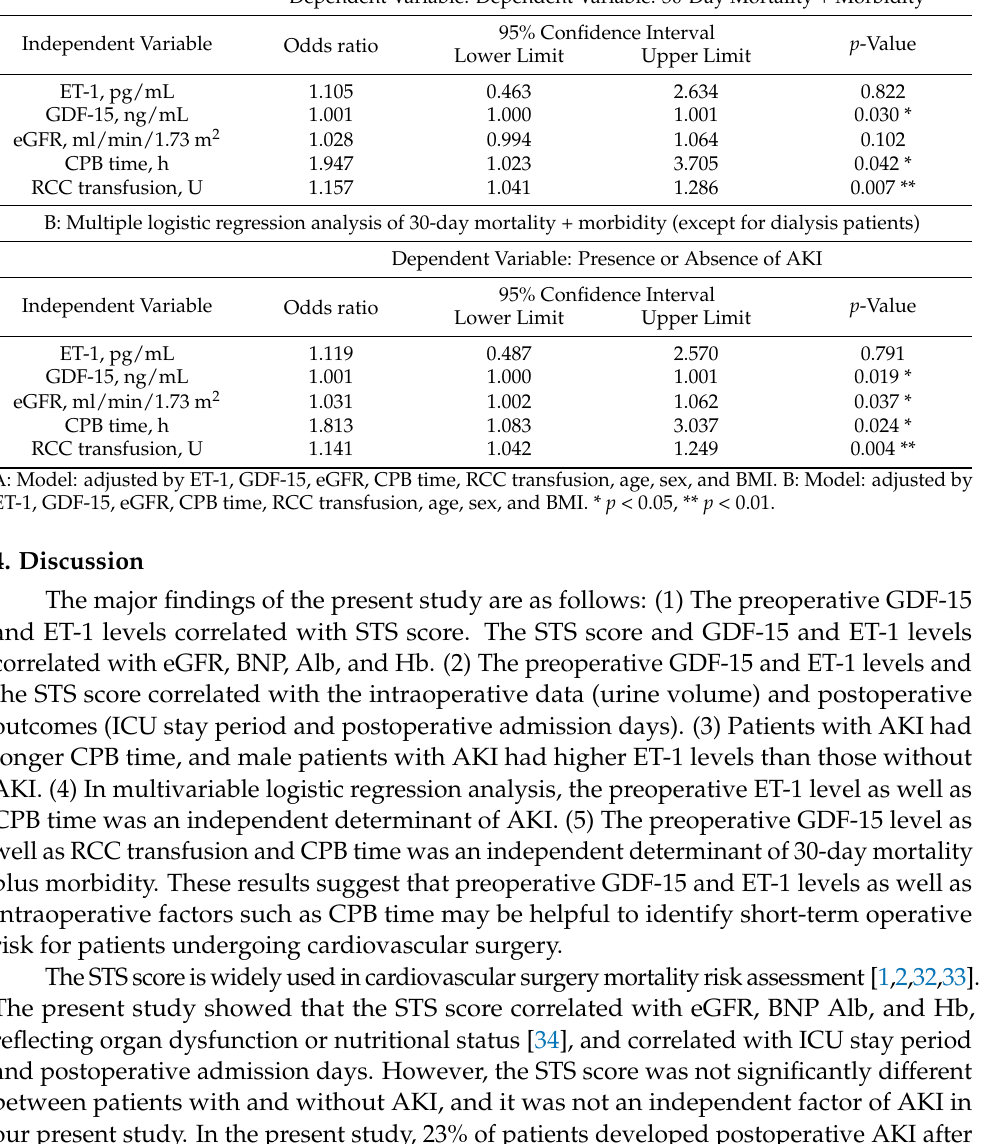
Table 5. Multiple logistic regression analysis of 30-day mortality + morbidity and clinical data. A: Multiple logistic regression analysis of 30-day mortality + morbidity (total patients) Dependent Variable: Dependent Variable: 30-Day Mortality +